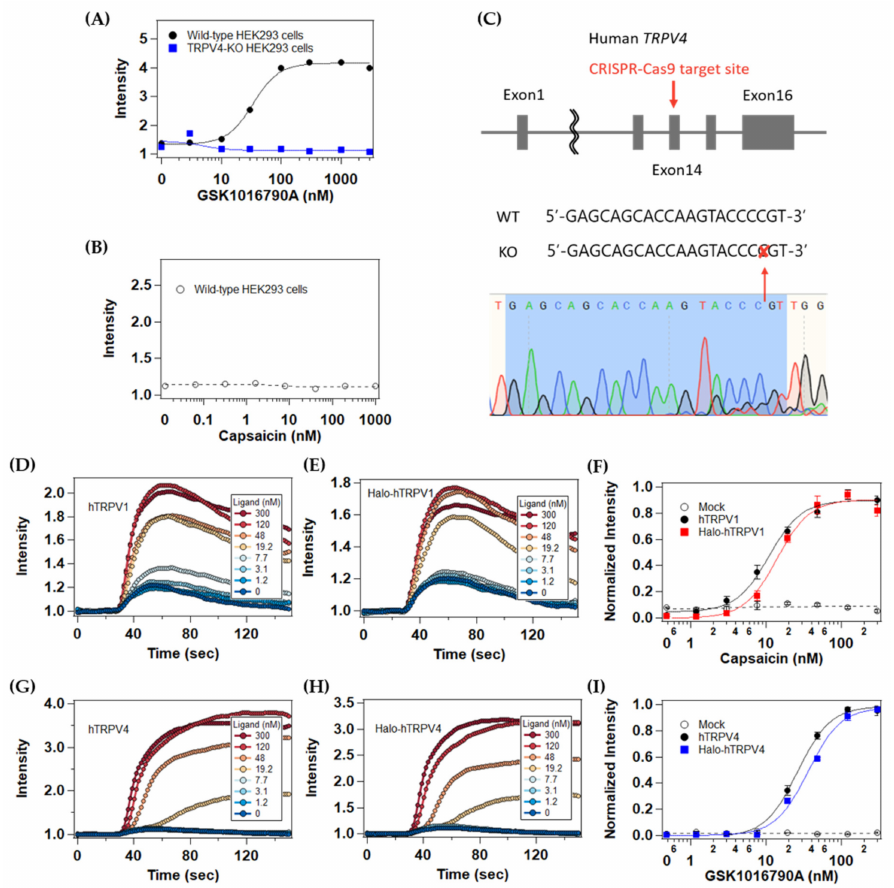
Figure 1. Evaluation of the effect of HaloTag fusion on human TRPV1 and TRPV4. ( A ) GSK1016790A dose-response curve in mock-transfected wild-type HEK293 cells (black) and mock-transfected TRPV4-KO HEK293 cells (blue). ( B ) Capsaicin dose-response curve in mock-transfected wild-type HEK293 cells (circle). ( C ) Sequencing results for the sgRNA target site in the human TRPV4 gene. ( D , E ) Representative capsaicin-induced Ca 2+ influx in TRPV4-KO HEK293 cells transfected with plasmid expressing wild-type hTRPV1 ( D ) or HaloTag-fused hTRPV1 ( E ). ( F ) Capsaicin dose-response curve in mock-transfected cells (circle), wild-type-hTRPV1-expressing cells (black filled circle), or Halo-Tag-fused-hTRPV1expressing cells (red). ( G , H ) Representative GSK1016790A-induced Ca 2+ influx in TRPV4-KO HEK293 cells transfected with plasmid expressing wild-type hTRPV4 ( G ) or HaloTag-fused hTRPV4 ( H ). ( I ) GSK1016790A dose-response curves of mock-transfected cells (circle), wild-type-hTRPV4-expressing cells (black filled circle), and HaloTag-fused-hTRPV4-expressing cells (blue). Data in ( F , I ) are means ± SEM of three independent